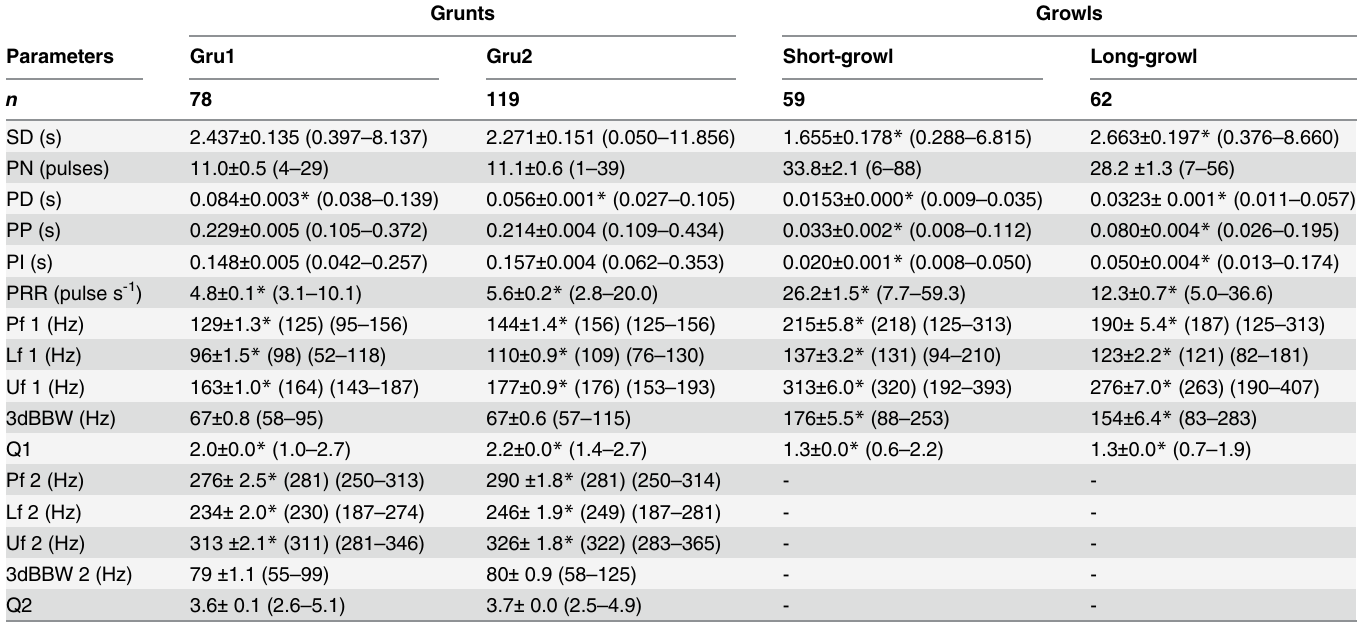
Table 3. Acoustic features measured in Gru1, Gru2, Short-growl and Long-growl sounds. Values are means ± SEM and range is given in parentheses below. For Pf, Lf and Uf the median value is given in parentheses on the right. SD = sound duration; PN = number of pulses; PD = pulse duration; PP = pulse period; PI = pulse interval; PRR = pulse repetition rate; Pf = peak frequency; Lf = lower frequency; Uf = upper frequency 3dBBW = 3 dB bandwidth; Q = damping coefficient. * = significant difference between means within each of the two different types of grunts and growls using t-tests at (P < 0.05) with sequential Holm-Bonferroni correction for Type I error